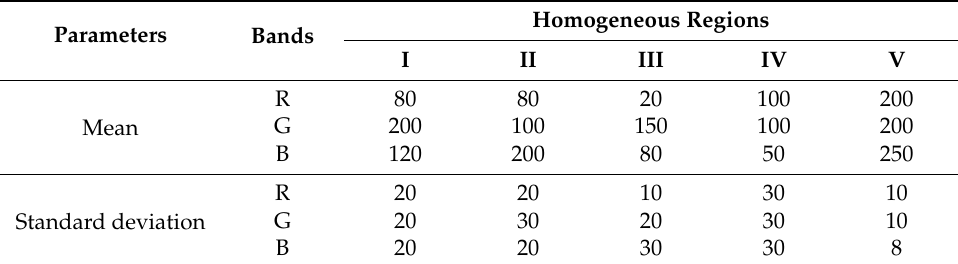
Figure 6. Simulated image and template. ( a ) Simulated image; ( b ) Template with five homogeneous regions. Table 2. Gaussian distribution parameters for generating the simulated